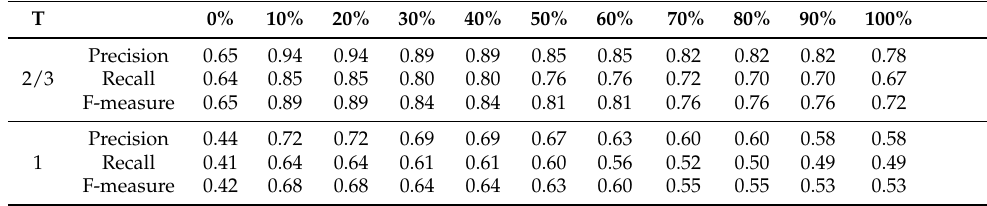
Table 7. Scene 1: precision, recall, and F-measure values for groups detected by robot. T